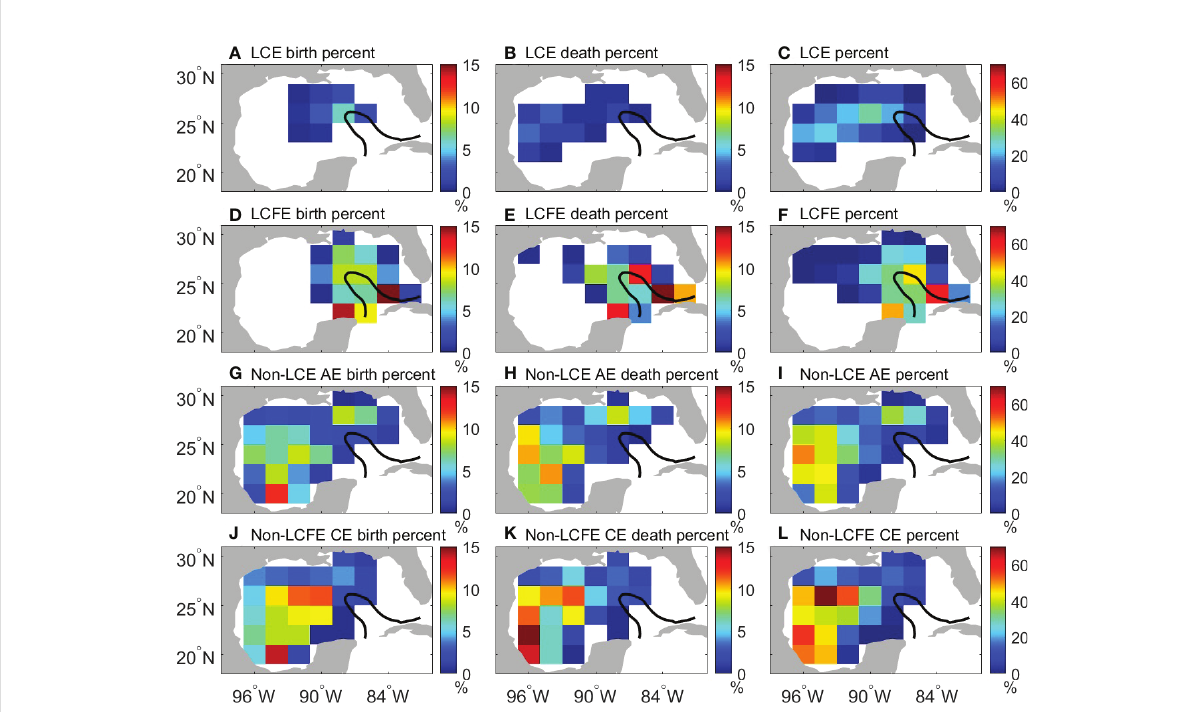
FIGURE 3 (A, D, G, J) The percentage of months when eddy birth was observed from January 1993 to April 2019. (B, E, H, K) The percentage of months when eddy death was observed. (C, F, I, L) The percentage of months when the presence of eddy was observed. LCEs, LCFEs, non-LCE AEs, non-LCFE CEs are shown in (A-C) , (D-F) , (G-I) , and (J-L) , respectively. The black line represents the 25-cm contour of temporal mean SSH anomalies from 1993 to